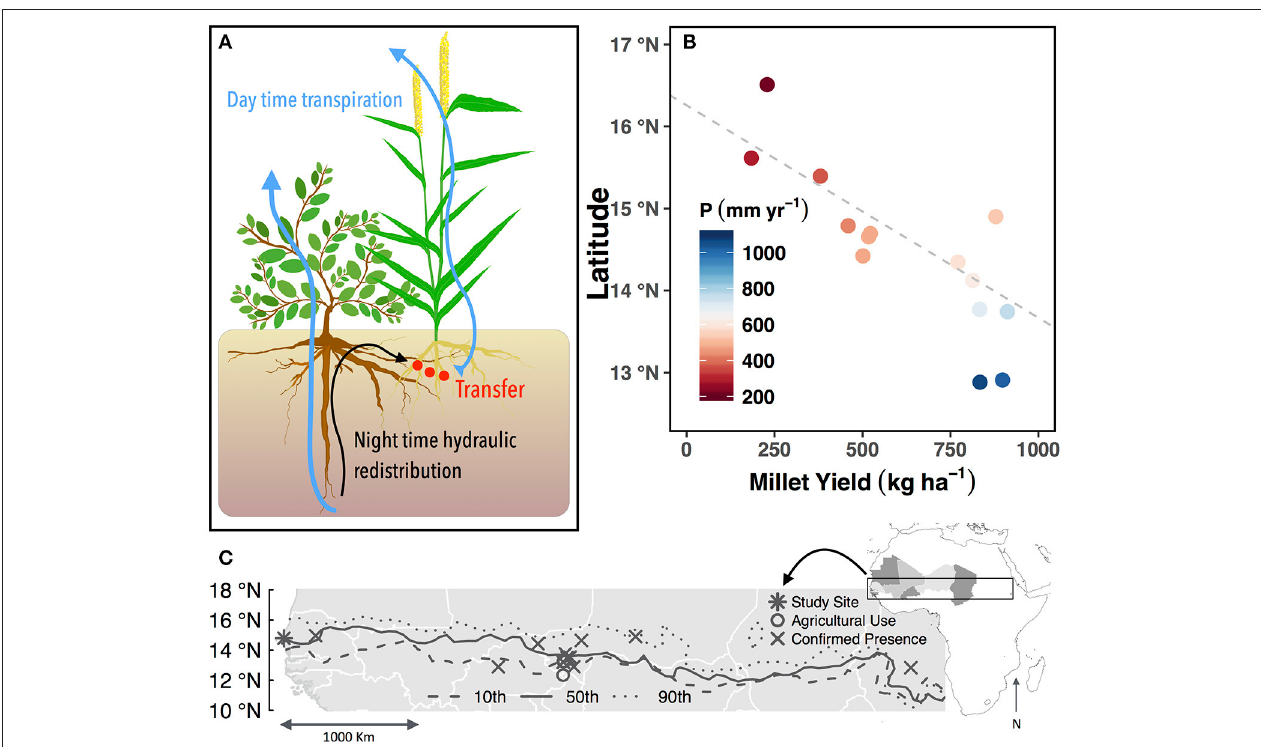
FIGURE 1 | Conceptual figure showing Guiera senegalensis and associated Pennisetum Glaucum (pearl millet) (A) . Mean annual millet yield across latitudinal transect in Senegal over the years 1987–2002. Mean annual precipitation for the same time period is indicated by color. Fitted line represents linear relationship of latitude and yield with values below 800mm of mean annual precipitation (r 2 = 0.68) (B) . Map of the Sahel showing published locations of G. senegalensis and the median, and 10th and 90th percentiles of the 500mm isohyet to illustrate the interannual variability of the precipitation (C)